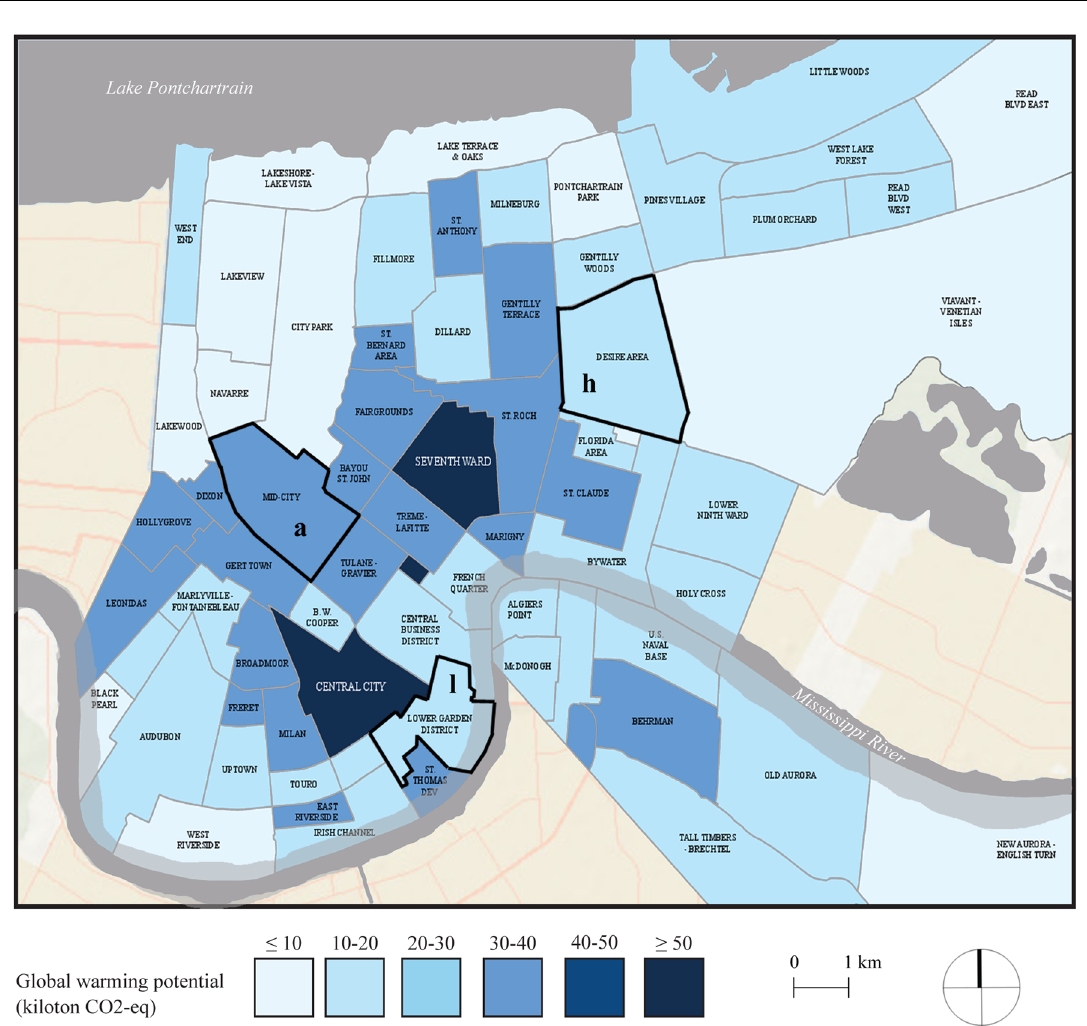
Fig. 5 Distribution of global warming potential across urban New Orleans neighborhoods from temporary housing deployment following a category 4 hurricane. Three neighborhoods have been identified as representative of low (l), average (a), and high social vulnerability